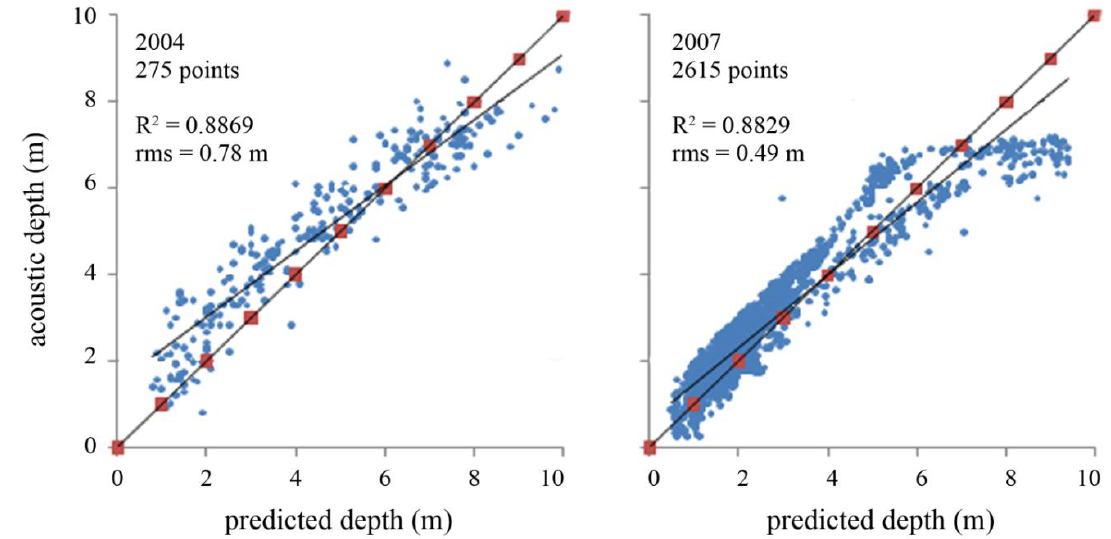
Figure 3. Scatter plot showing Lyzenga predicted depth vs. acoustic depth from field data points for 2004 (left) and 2007 (right) image data. Line with squares = 1:1 line; plain line = line of best